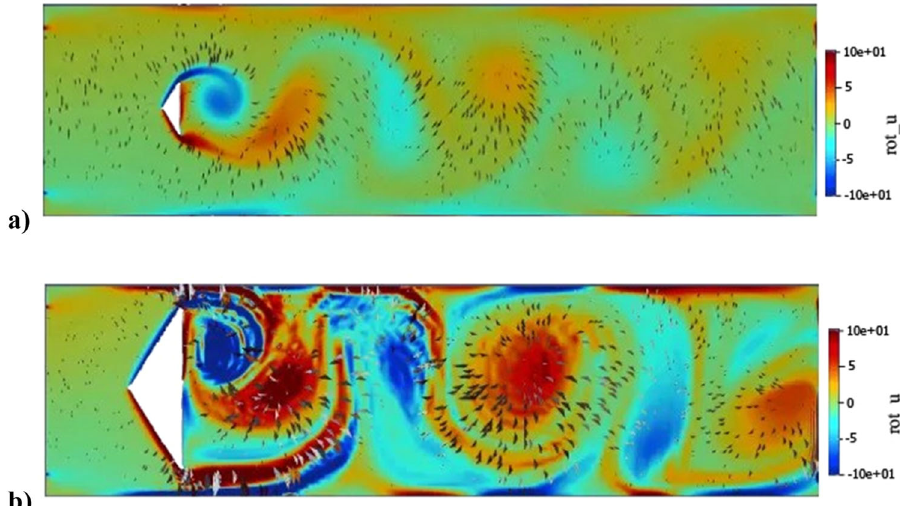
Fig. 2 A snap shot of vorticity. a SVF experiment. b LVF experiment at 41 s. Vorticity (rot_u) is displayed from -10 to 10 s -1 based on the bar on the right, in the fl ow channel calculated by the 2-D computational model. The arrows indicate the direction of fl ow and the intensity of the